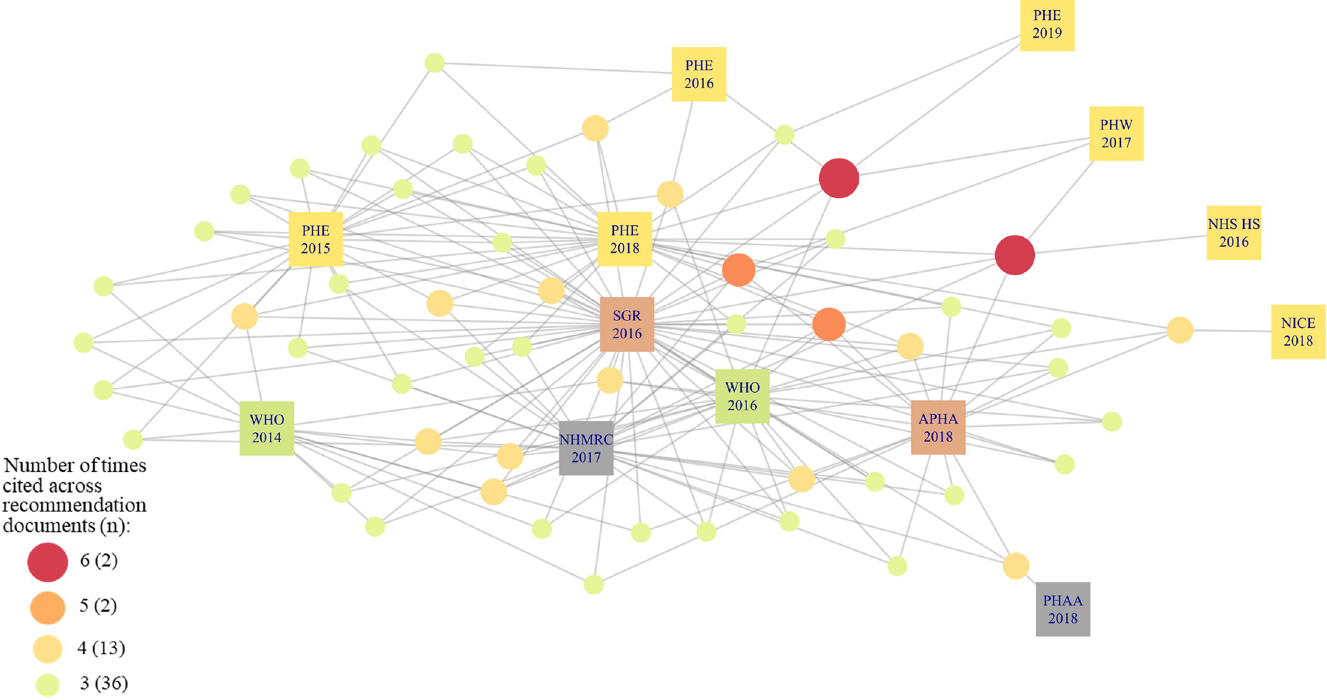
Fig 2. Citation network for the 53 most highly cited citations across 13 recommendation